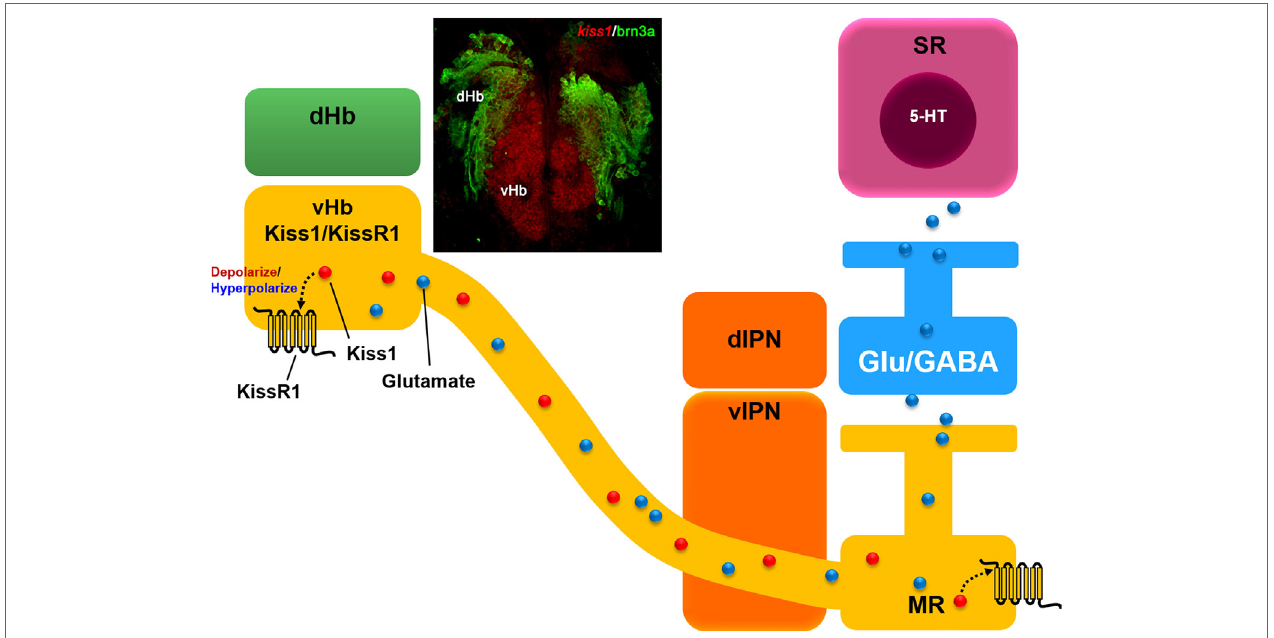
FiGURe 1 | Schematic drawing of hypothetical neural circuit of habenular kisspeptin 1 (Kiss1) neurons. Kiss1 (red dot) modulate ventral habenular (vHb) neuronal activities via concentration­dependent mechanism through co­expressing Kiss1 receptor (KissR1). Photomicrograph shows a coronal brain section image of kiss1 mRNA expression in the vHb (red) but not in the dorsal habenula (dHb, green) expressing brn3a , a marker gene for the dHb in transgenic ( brn3a-hsp70:GFP ) zebrafish. Habenular Kiss1 neurons send their projections to the median raphe (MR), a division of the superior raphe (SR). Kiss1 cells are glutamatergic in nature and it is hypothesized that the presynaptic action of the Kiss1/KissR1 system causes the release of glutamate (blue dot) in Kiss1 cells from the vHb that potentially regulates the serotonin (5­HT) system in the SR directly or via glutamatergic and GABAergic neurotransmission. Abbreviations: dIPN, dorsal interpeduncular nucleus; vIPN, ventral interpeduncular nucleus modified from Nathan et al.